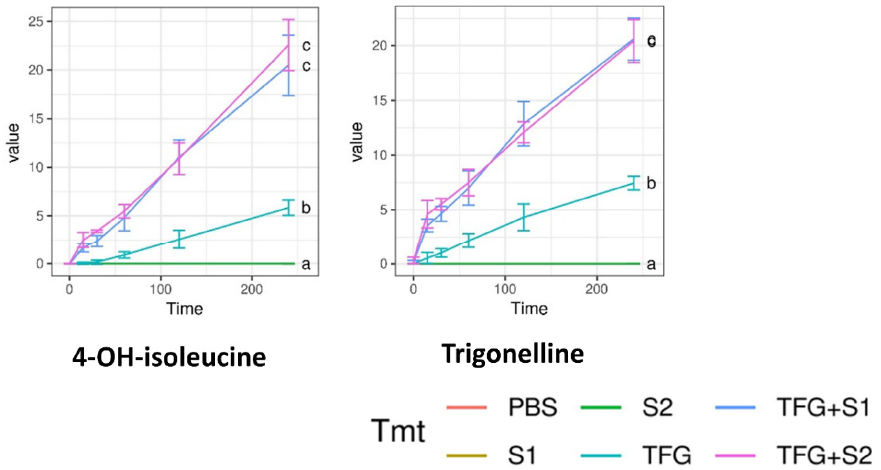
Figure 5. Abundance of Trigonella foenum-graecum compounds in the basal layer of Caco-2 cells, as measured by LC-ESI-MS. 4-hydroxyisoleucine and trigonelline were measured in positive ion mode. Data are given in µ g · mL − 1 for 4-hydroxyisoleucine and trigonelline. Abbreviations denote the compositions of the upper layer, as in Table 3. The curves marked with different letters differ significantly, according to Tukey’s HSD post-hoc test.